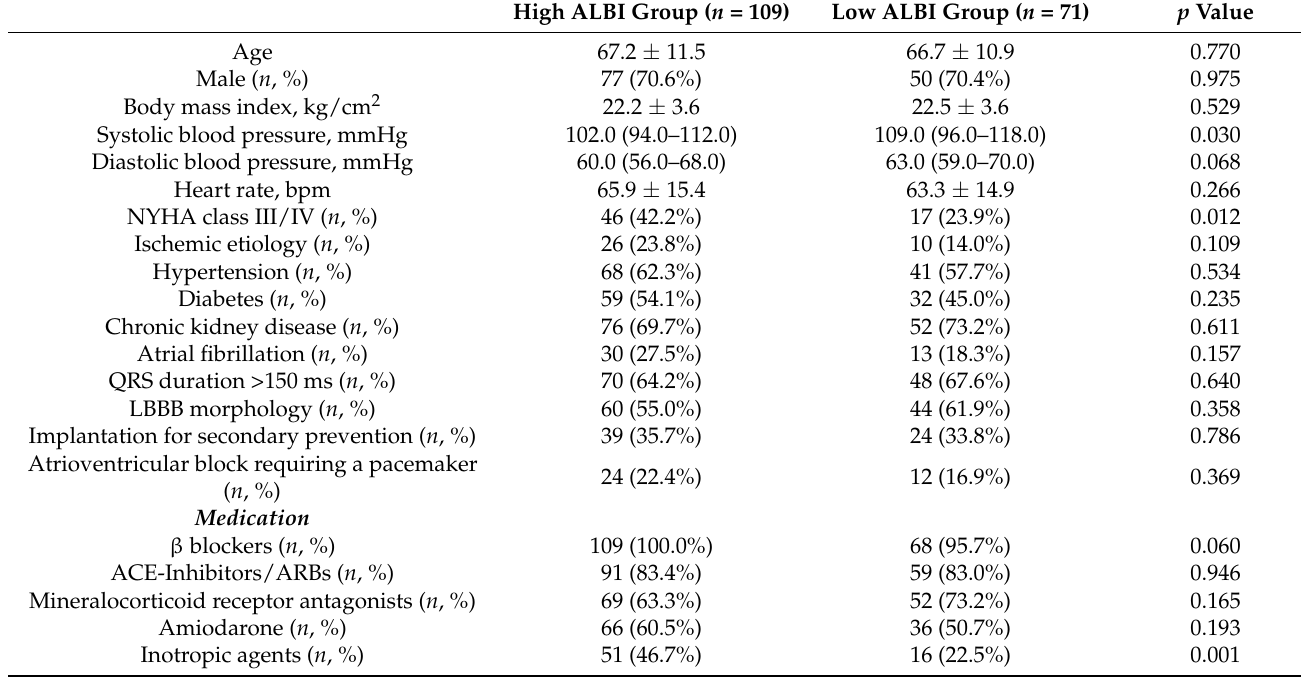
Table 1. Comparison of baseline clinical characteristics for the High and Low ALBI groups. High ALBI Group ( n =